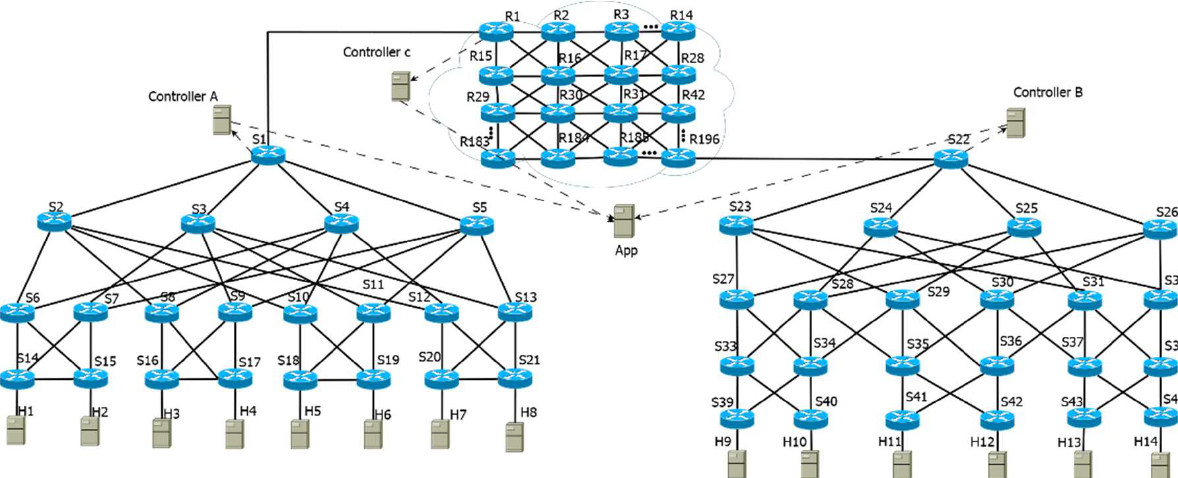
Figure 6. Experimental topology.